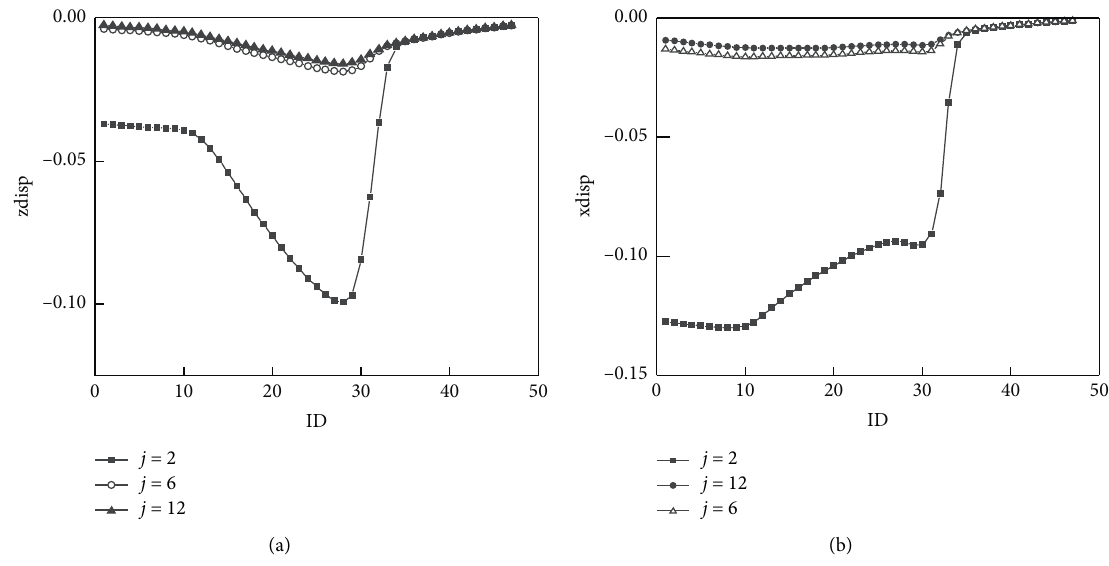
Figure 18: Displacement of the dumping step. (a) Vertical displacement. (b) Horizontal